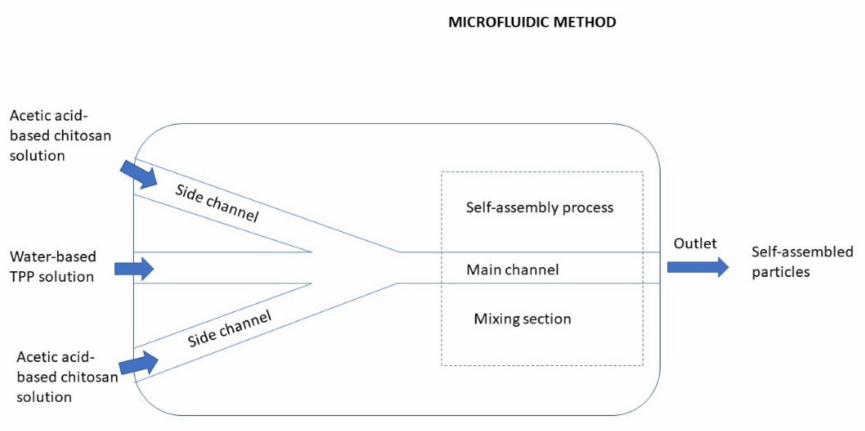
Figure 13. Preparation of CS NPs by the microfluidic